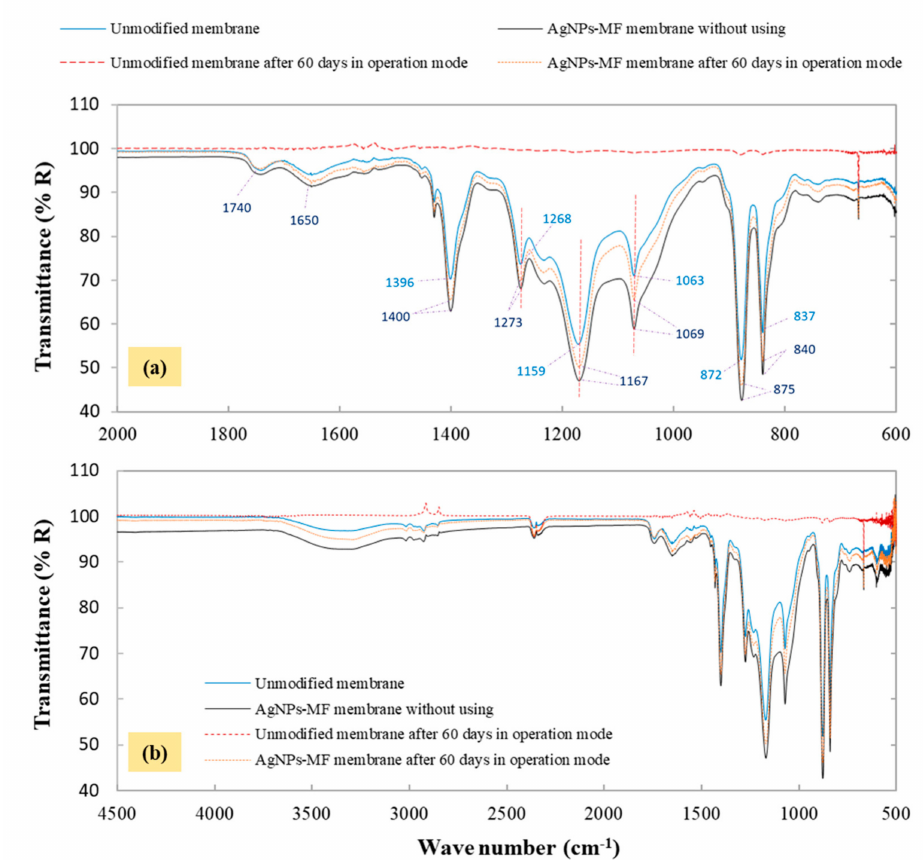
Figure 8. FTIR spectra of the membranes analyzed before and after the experiment in the wavenumber range of ( a ) 2000 to 600 cm − 1 and ( b ) 4500 to 500 cm − 1